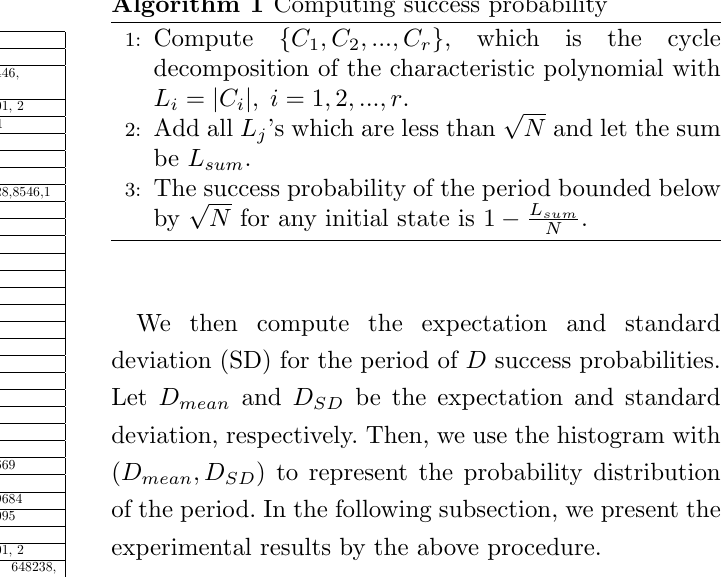
Table 4. Complete cycle decompositions of the WG- NLFSR for n = 3 over F 2